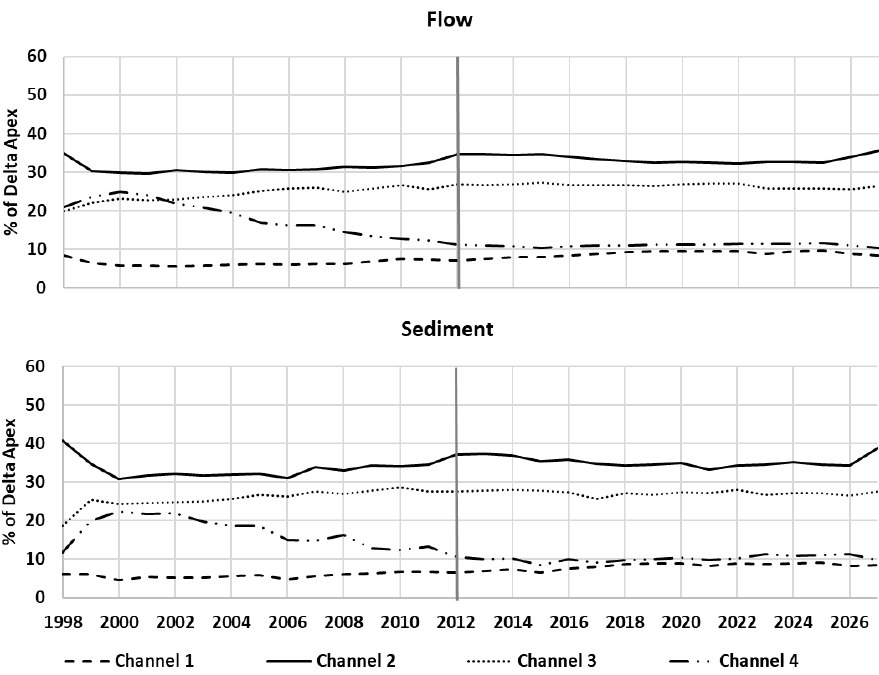
Figure 14. Flow and sediment (total- fines and sand) distribution in the distributary channels for 30 years. The first 15- year simulation ends in year